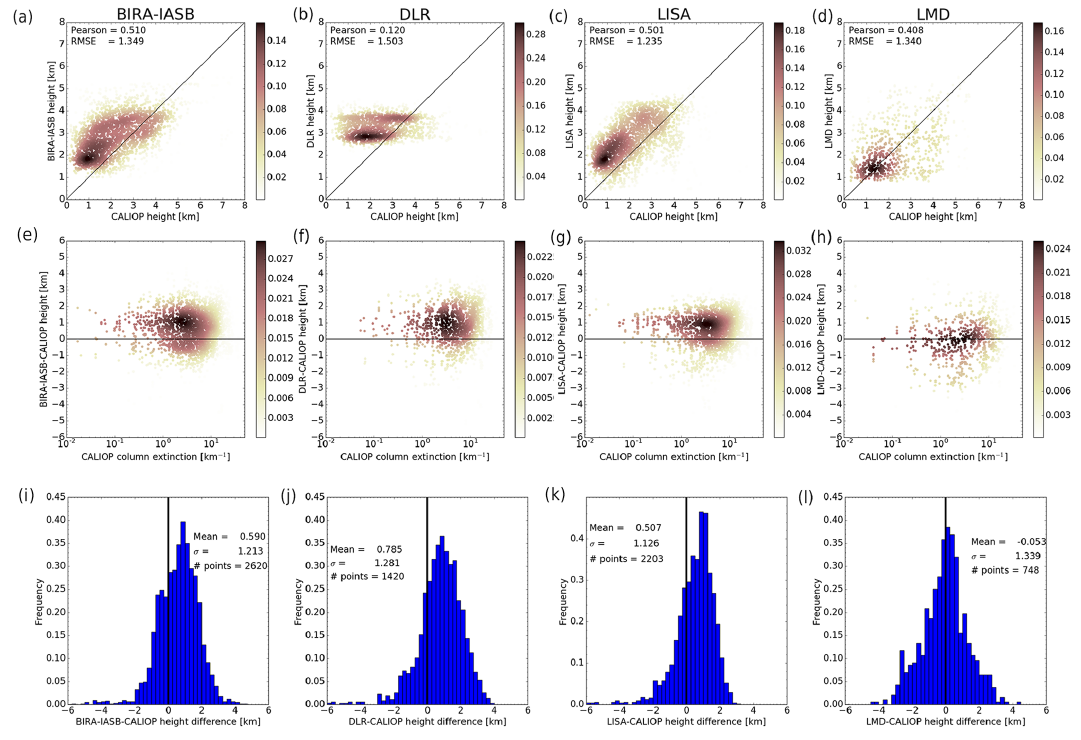
Figure 5. (a–d) The probability density, using kernel density estimation, of the CALIOP cumulative extinction height versus height from the various algorithms. Also given are the Pearson’s correlation coefficient and root mean square error (RMSE). (e–h) The probability density, using kernel density estimation, of the difference between the passive algorithm and the CALIOP cumulative extinction heights versus the CALIOP column extinction. (i–l) Frequency distribution of the difference between the height from the various algorithms and the CALIOP cumulative extinction height. The mean and standard deviation ( σ ) together with the number data points are given in each plot. This information is also provided in Table 3. Data are shown for the BIRA-IASB (a, e, i) , DLR (b, f, j) , LISA (c, g, k) and LMD (d, h, l)